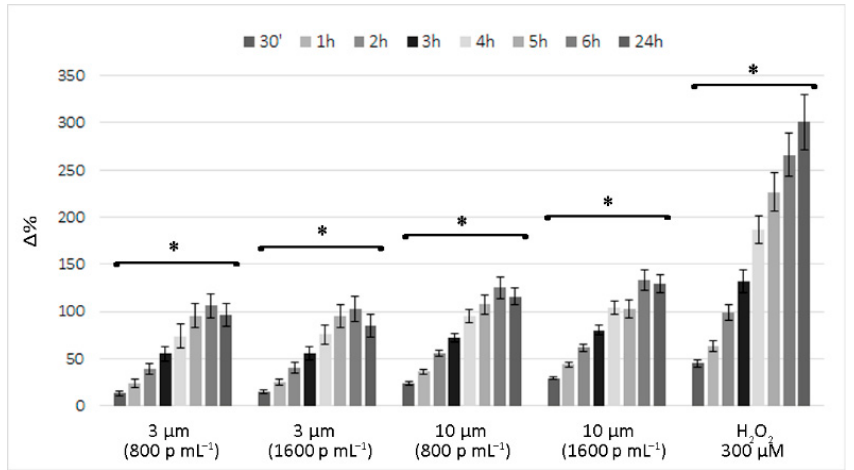
Figure 1. Membrane destabilization of the acidic vacuolar compartment in PS- MPs exposed cells. Images of acridine orange (AO)-loaded cells (400x magnifications) are reported: ( A ) Untreated cells showing intact lysosomes. ( B , C ) HT-29 treated with PS- MPs (800 p mL − 1 for 24 h) 3 and 10 µ respectively. Diffuse green cytosolic fluorescence and the reduced number of red dots, in B images highlight the damage to late endosomes and lysosomes.